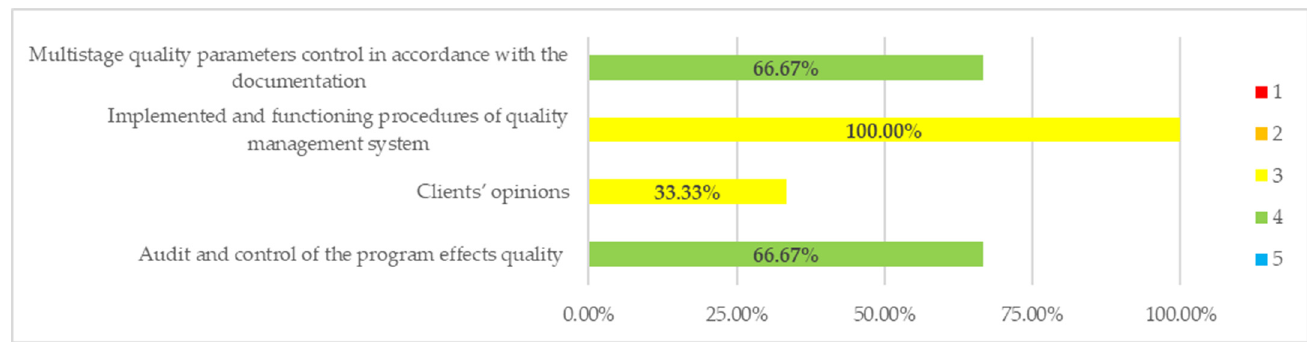
Figure 10. Evaluation of the effectiveness of the methods, techniques and tools used for the quality control process. Source: own elab.